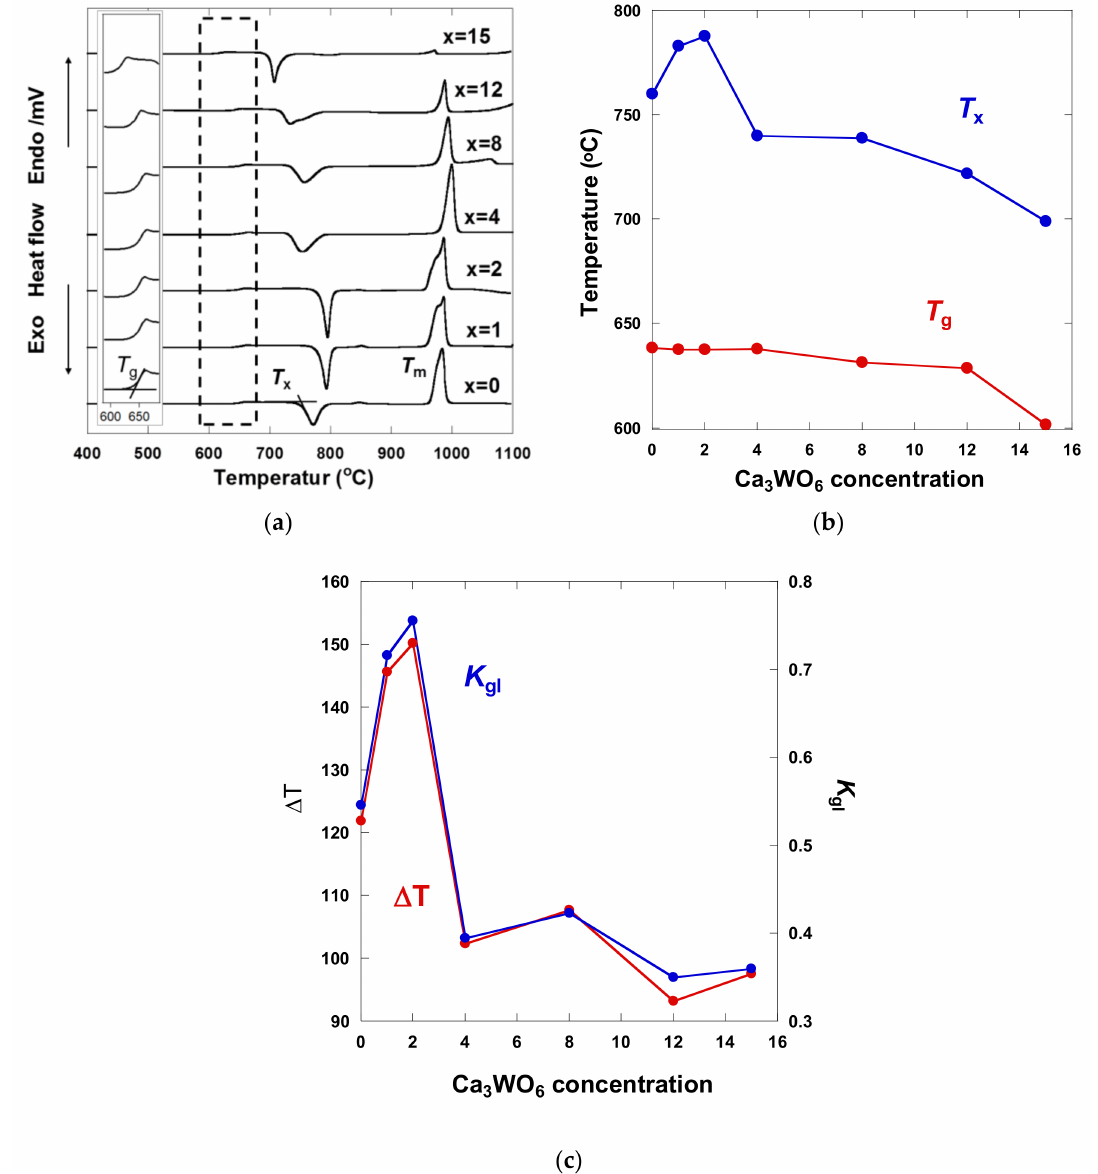
Figure 5. ( a ) DSC curves of (100 − x ) (33CaO-67B 2 O 3 ) − x Ca 3 WO 6 glasses with an insertion of the expanded figure around T g , ( b ) The values of T g and T x , and ( c ) ∆ T and K gl as a function of Ca 3 WO 6